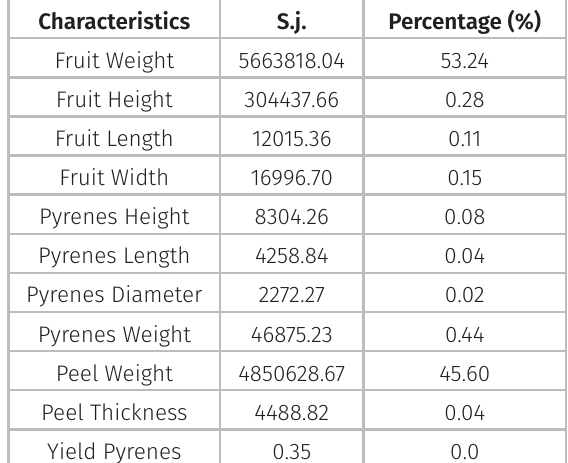
Table V. Relative contribution of the morphometric characteristics of Caryocar brasiliense fruits with and without thorns in the endocarp to the divergence of Singh